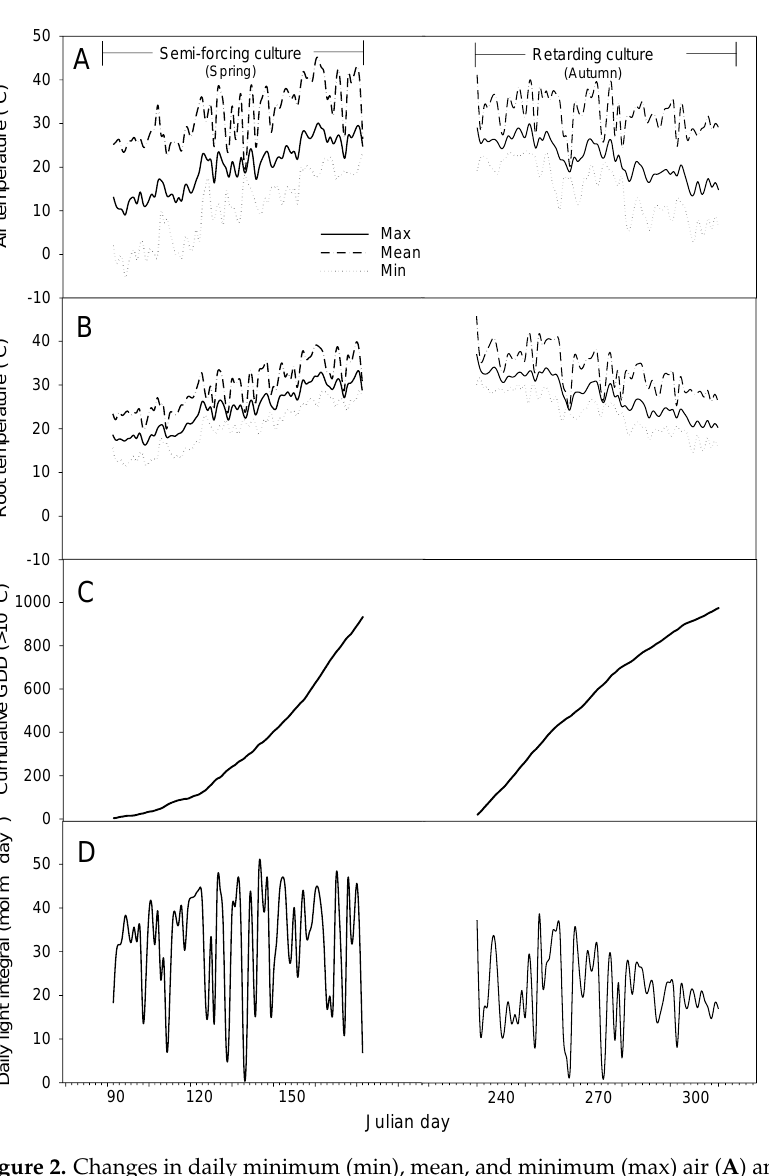
Figure 2. Changes in daily minimum (min), mean, and minimum (max) air ( A ) and root temperature ( B ), cumulative GDD ( C ), and daily light integral ( D ) during semi-forcing (March to June) and retarding culture (August to October).